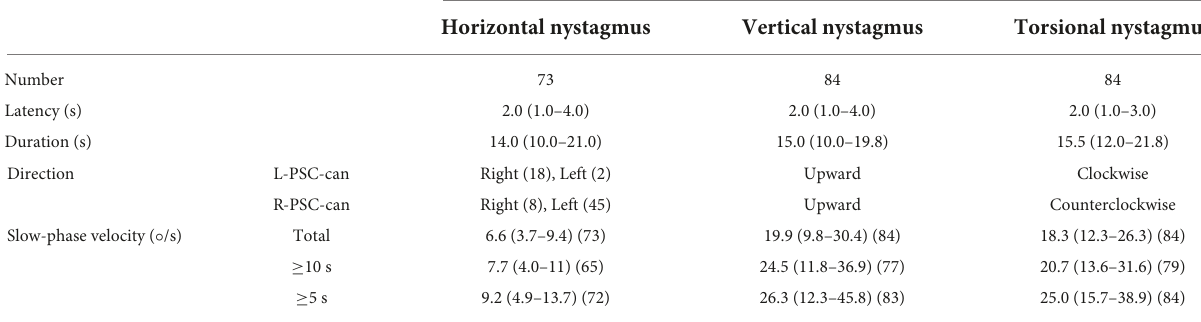
TABLE 3 Nystagmus characteristics of the sitting position in 84 patients with PSC-can.